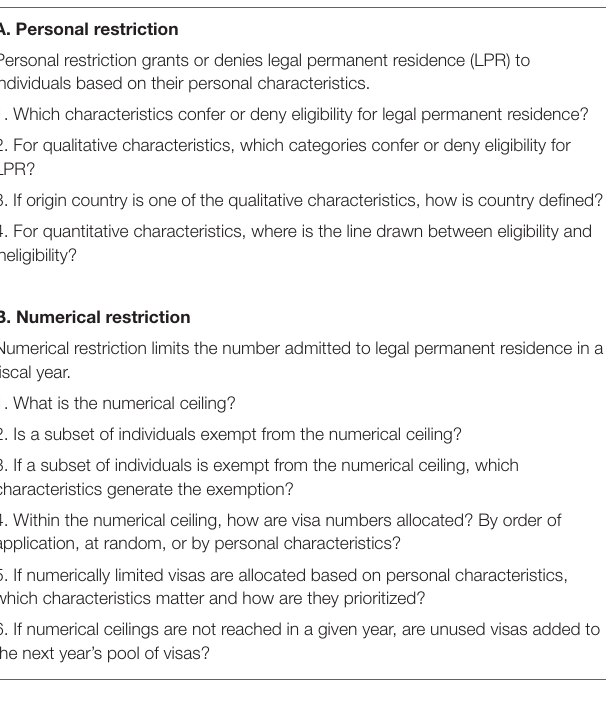
TABLE 1 | Apparatus for migration restriction: initial